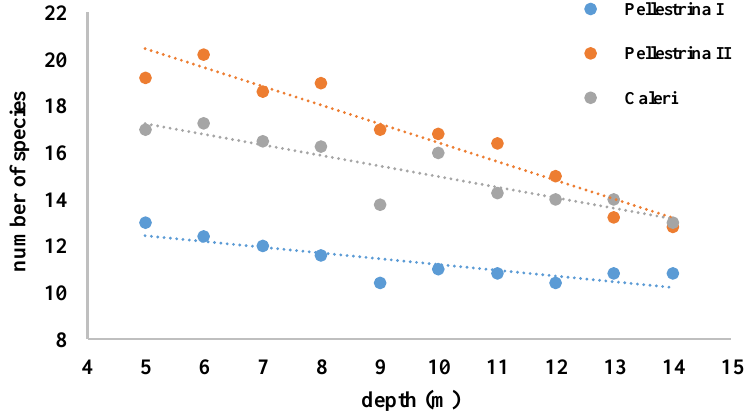
Figure 4. Richness found in Pellestrina I, Pellestrina II and Caleri samples at different depths.